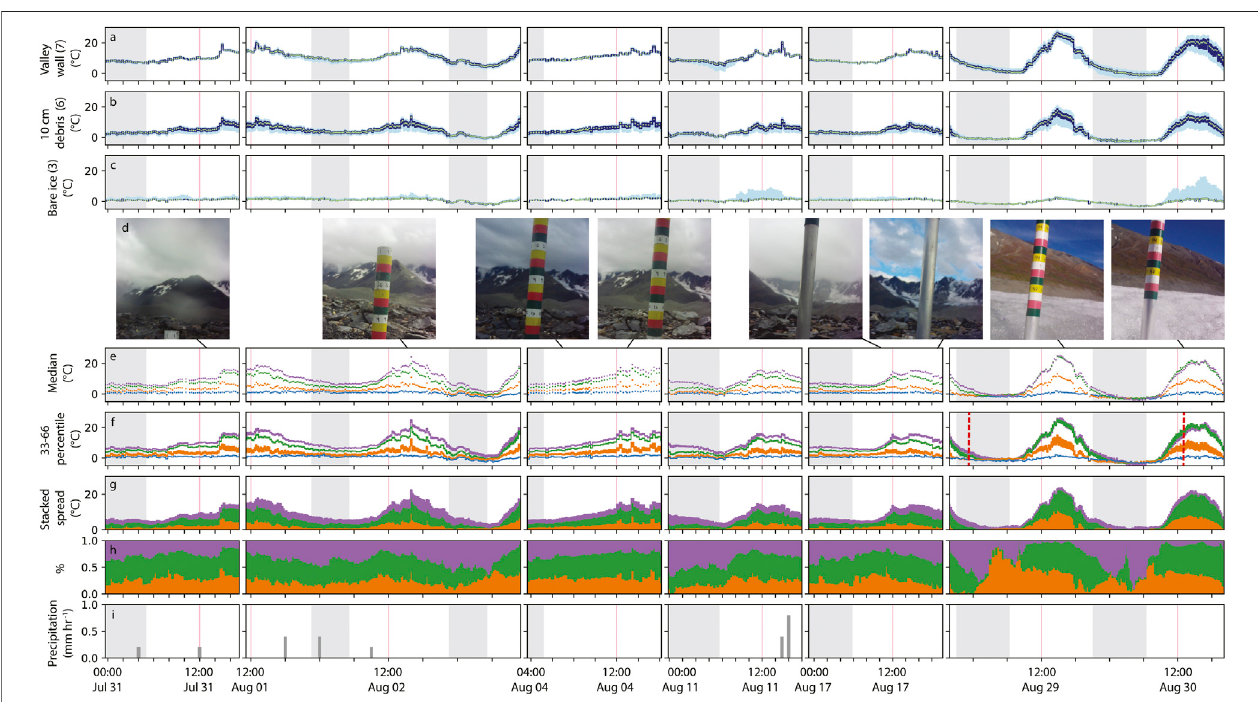
FIGURE 4 | (A – C) segments where glacier melt was not measured. Location from Figure 1 is given on the y -axis label. Light and dark blue are the 10 – 90 and 33 – 66percentiletemperaturerange,respectively.Thegreendotisthesegmentmediantemperature. (D) selectimagesfromtheglaciersel fi esticks.Ignoringtheablation stake in the center frame, cloudiness and the local weather can be observed. Segment median temperature (E) and 33 – 66 percentile range (F) for the four segments where ablation was measured. The colors correspond to: blue, bare glacier ice at Figure 1 location (5); orange, 4 cm debris thickness (4); green, 8 cm debris thickness(2);andpurple,38 cmdebristhickness(1). (G) spreadofmedianvaluesforsegmentsin (E) bystackingthegap,in ° C,betweentwoneighboringsegments.The difference swath is assigned the color of the upper segment. (H) same as (G) , normalized to 100%. (I) precipitation of liquid water. Solid red vertical lines show noon of each day, and grey swaths show the local night (corrected for local latitude). The two vertical red dashed lines in (F) show the timing of two ASTER thermal images that were acquired concurrently with this